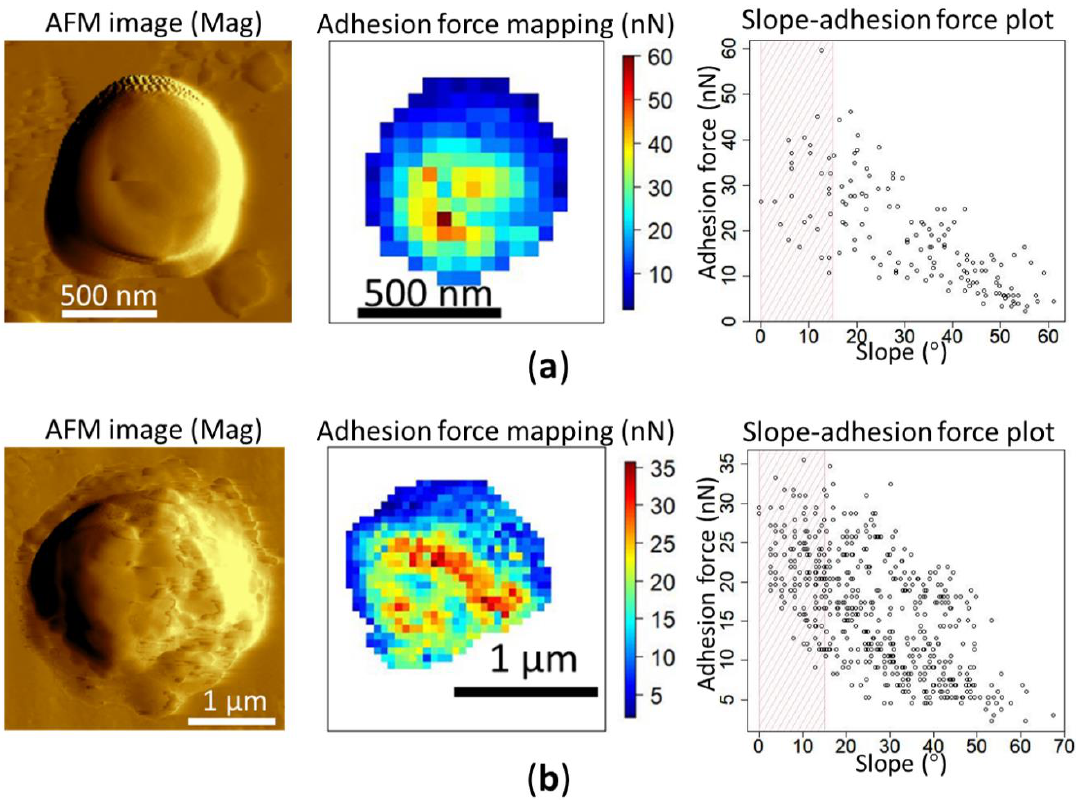
Figure 4. Atomic force microscopy (AFM) mag images, adhesion force mapping images, and slope – adhesion force plots of inorganic particles: ( a ) ammonium sulfate (AS) and ( b ) artificial sea salt (ASS). Corresponding AFM height and phase images can be found in Figure S4 in the Supplementary Information.